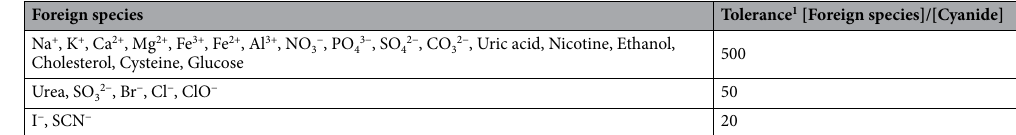
Table 2. The effect of foreign species on the response of assay to cyanide ions (40.0 µmol L −1 ). 1 The tolerance limit is introduce as the amount of foreign species in the present of cyanide leading to a relative error less than 5% in the determination of cyanide.